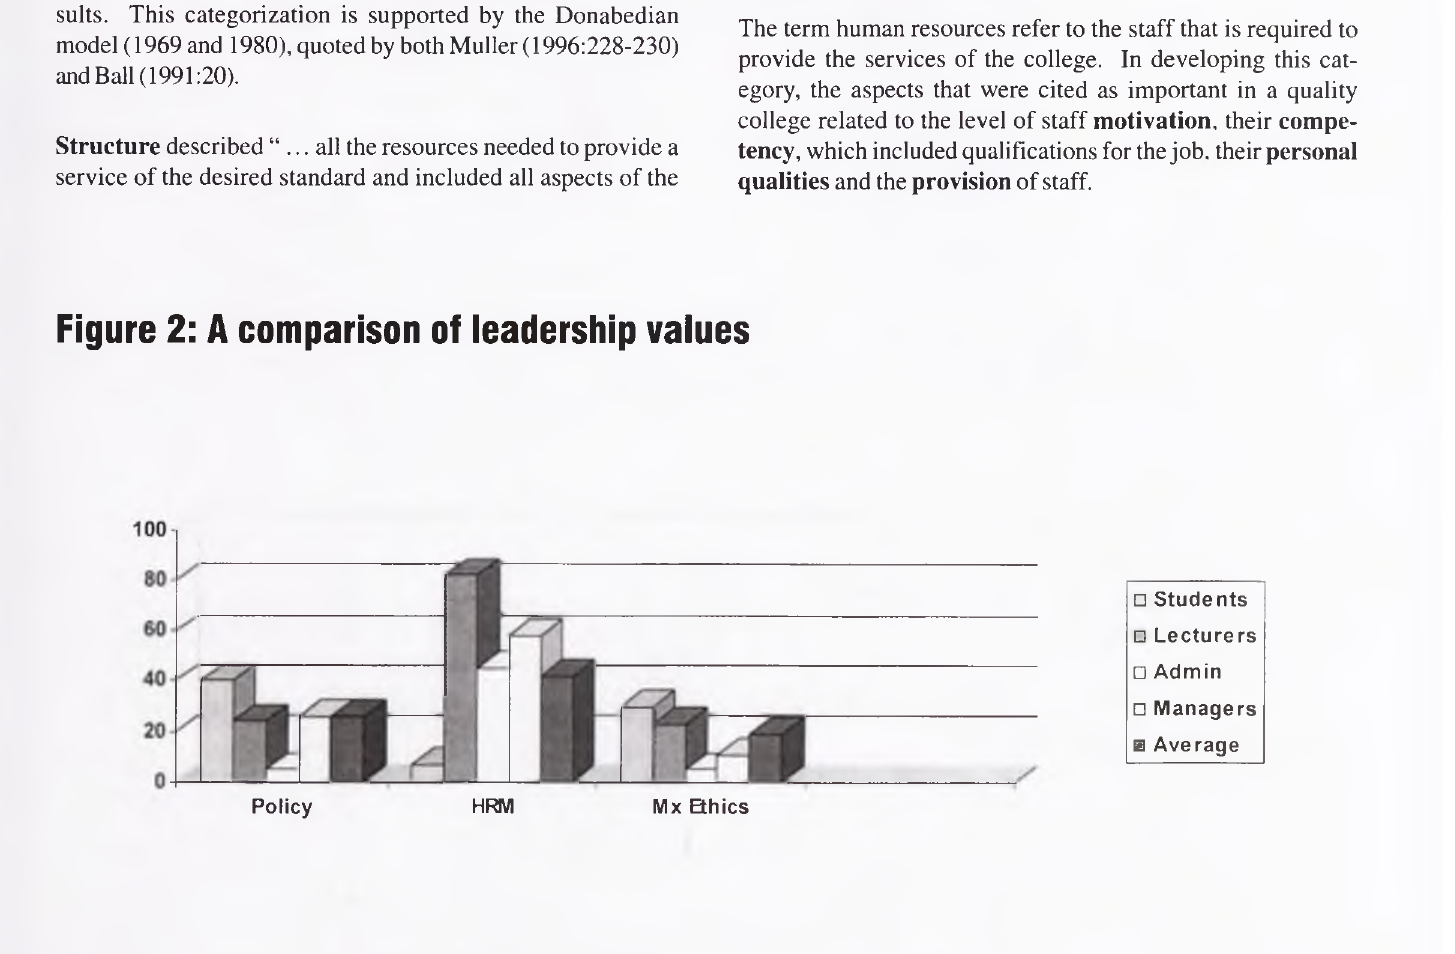
Figure 2: A comparison of leadership